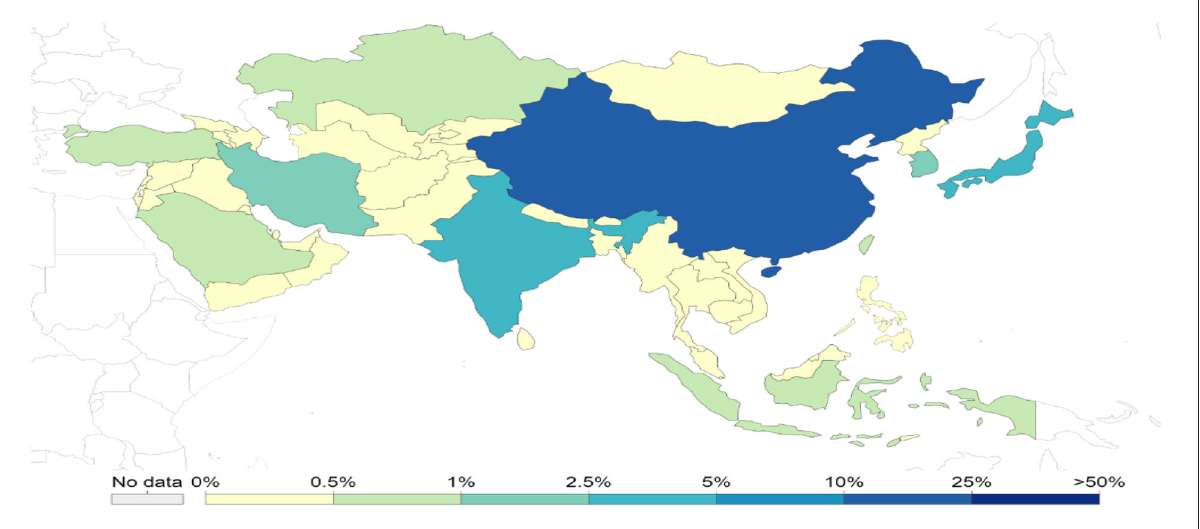
FIGURE1 Share of each Asian country in cumulative global carbon dioxide emission (1751–2019; Source: OWID based on CDIAC and Global Carbon Project).